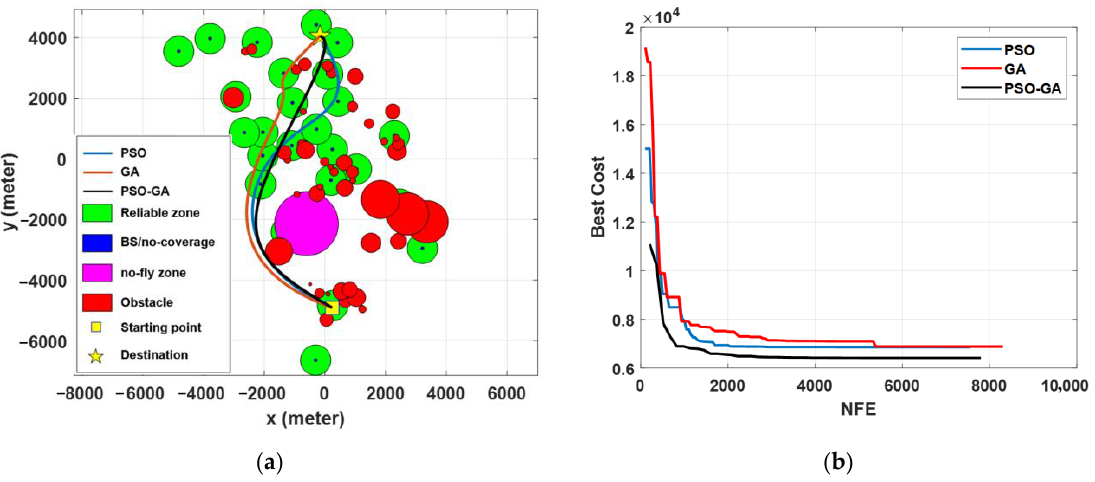
Figure 12. Simulation results of different optimization algorithms in Scenario III: ( a ) path planning results and ( b ) cost function value vs. the number of function evaluations.